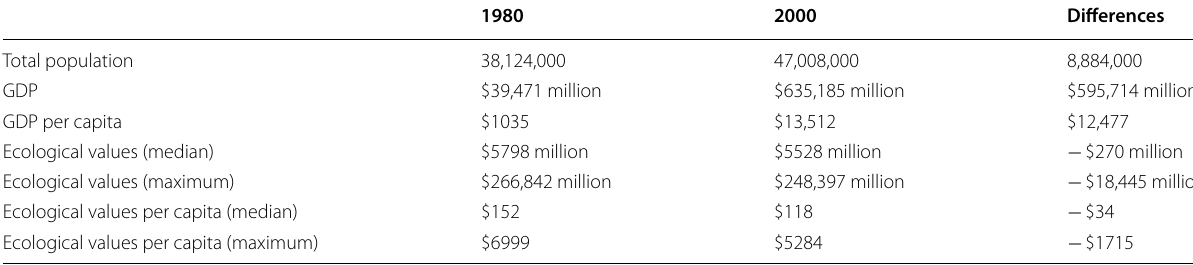
Table 8 GDP and ecological costs